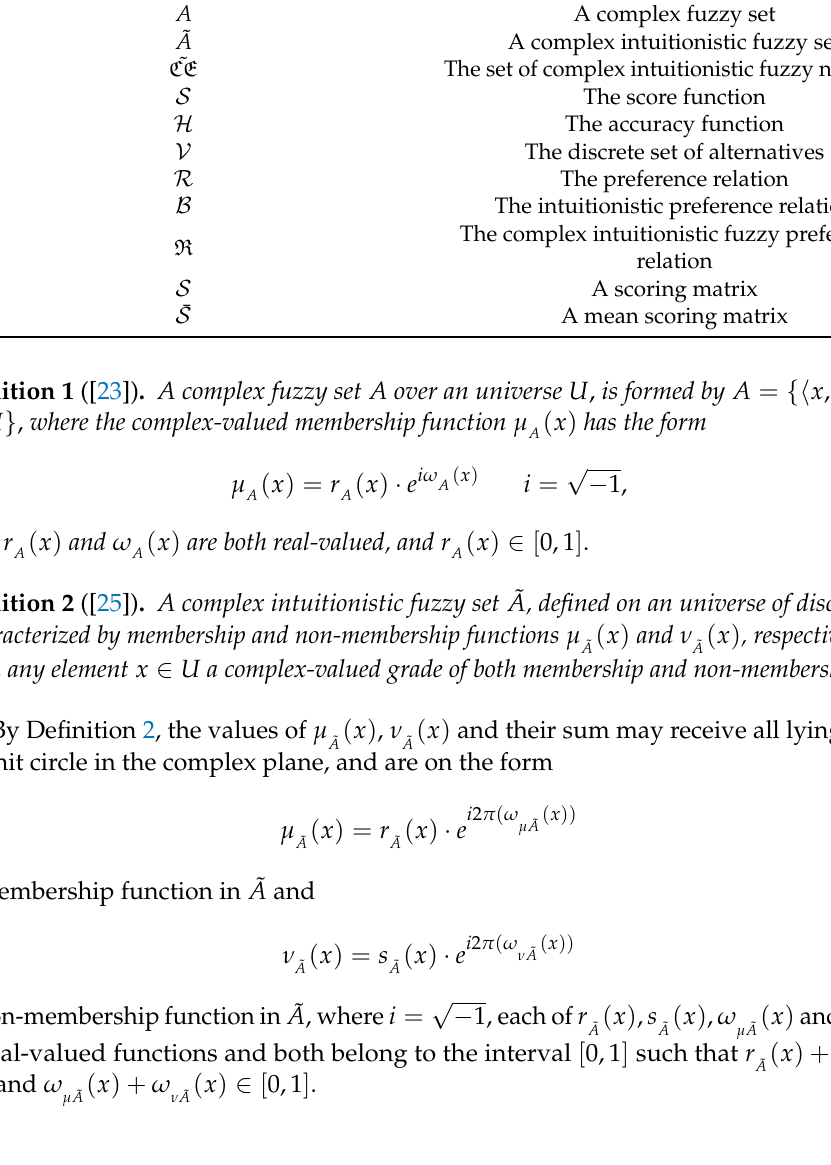
Table 1. Mathematical symbols and definitions. Mathematical Symbols Definitions A A complex fuzzy set ˜ A A complex intuitionistic fuzzy set ˜ CE The set of complex intuitionistic fuzzy numbers S The score function H The accuracy function V The discrete set of alternatives The preference relation The intuitionistic preference relation The complex intuitionistic fuzzy preference R